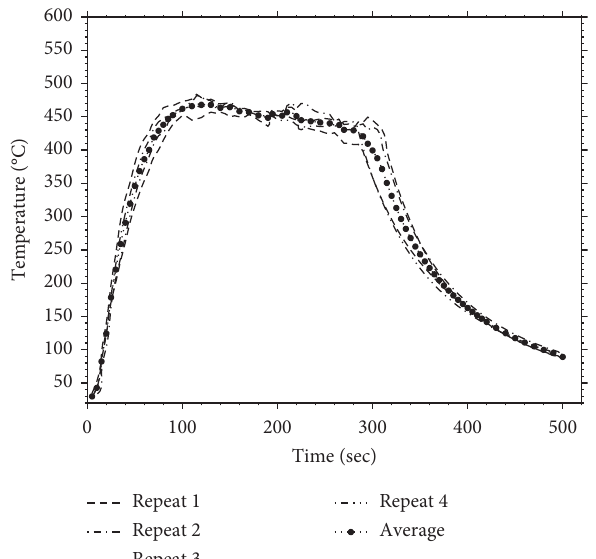
Figure 8: Evolution of temperature in the persistent zone of the flame during the four repeated tests: case of source 1.